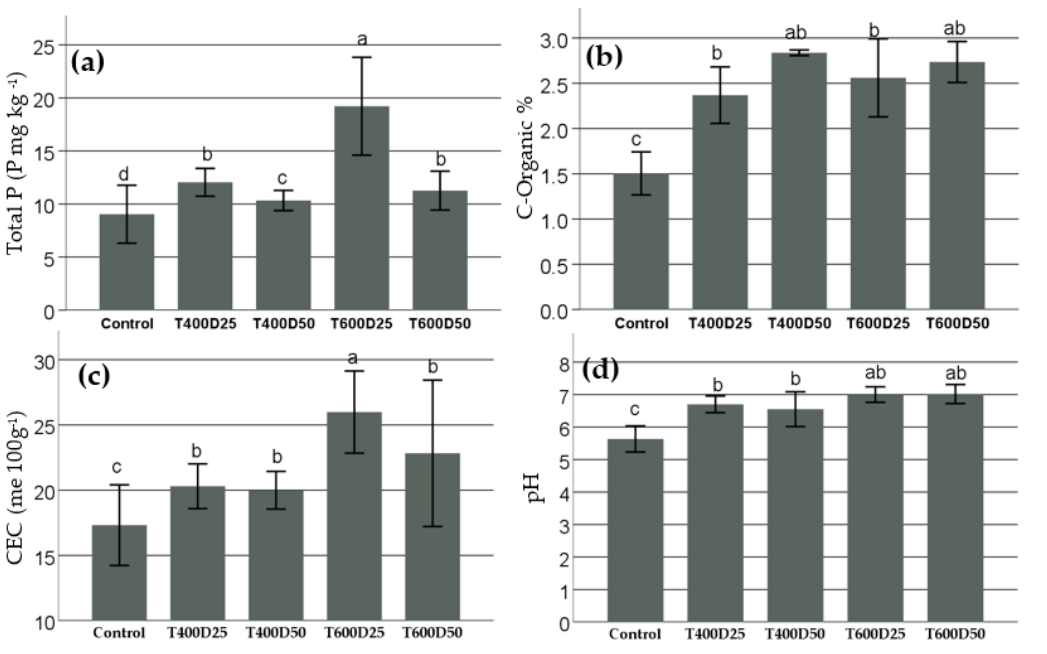
Figure 3. ( a ) P-total P, ( b ) organic-C, ( c ) CEC, and ( d ) pH in the five experimental treatments: dosage 0 t ha − 1 (control), dosage 25 t ha − 1 at 400 °C (D25T400), a dosage of 50 t ha − 1 at a temperature of 400 °C (D50T400), dosage 25 t ha − 1 at 600 °C (D25T600), and a dosage of 50 t ha − 1 at a temperature of 600 °C (D50T600) after six months planted in the field. Different letters above the bars indicate statistically significant differences between the sampling times within the same treatment ( p ≤ 0.05). Vertical bars represent the standard error of the mean.